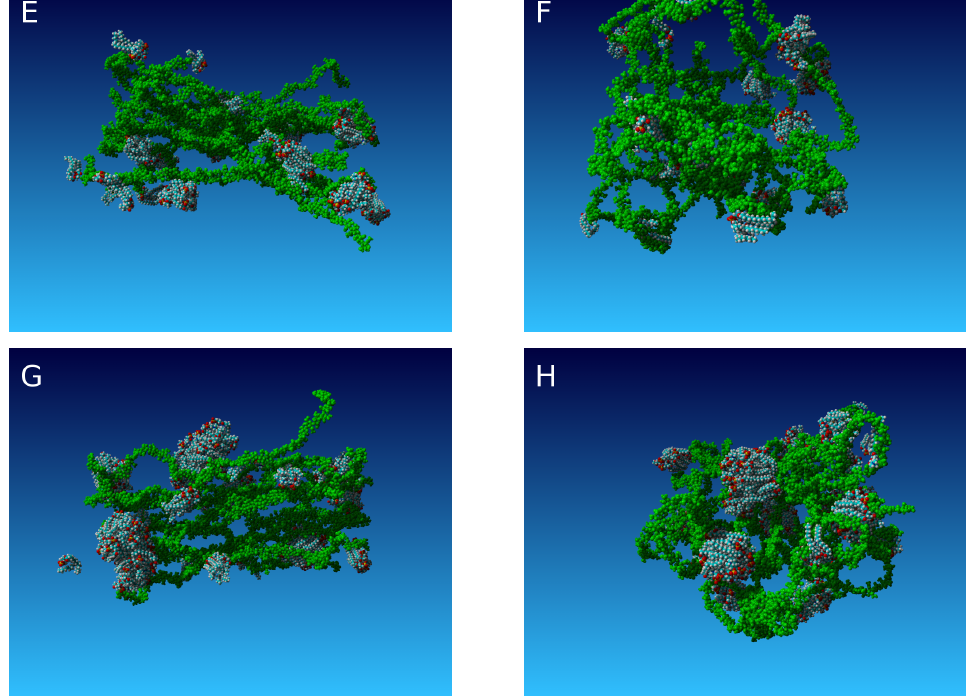
Figure 2. The structures of HA and PL at the end of the simulation: ( A , C , E , G ) results for a normal network; and ( B , D , F , H ) and for a pathological network. From ( A , B ) to ( G , H ), the number of phospholipids increases. Carbon atoms are depicted as blue; hydrogen as white; and nitrogen as yellow. Starting from the second row, HA is depicted as green for better visualization of PL orientation towards the HA network.